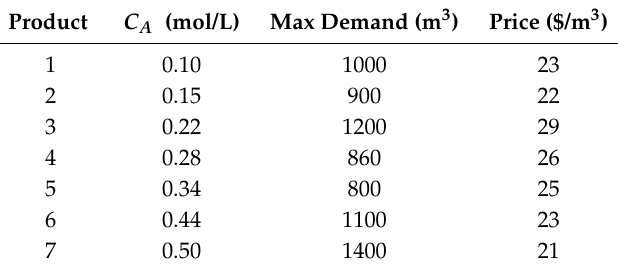
Table 7. Scenario 2: Product specifications.